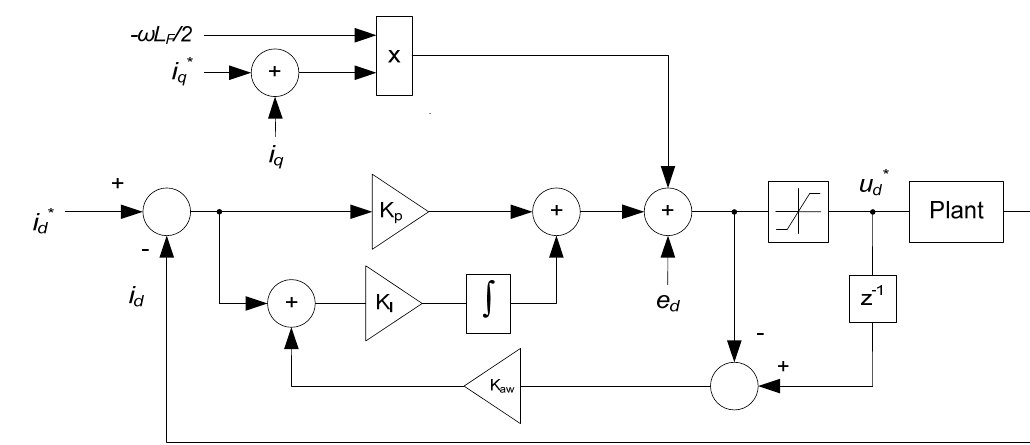
Figure 12. Block diagram of the d -axis current